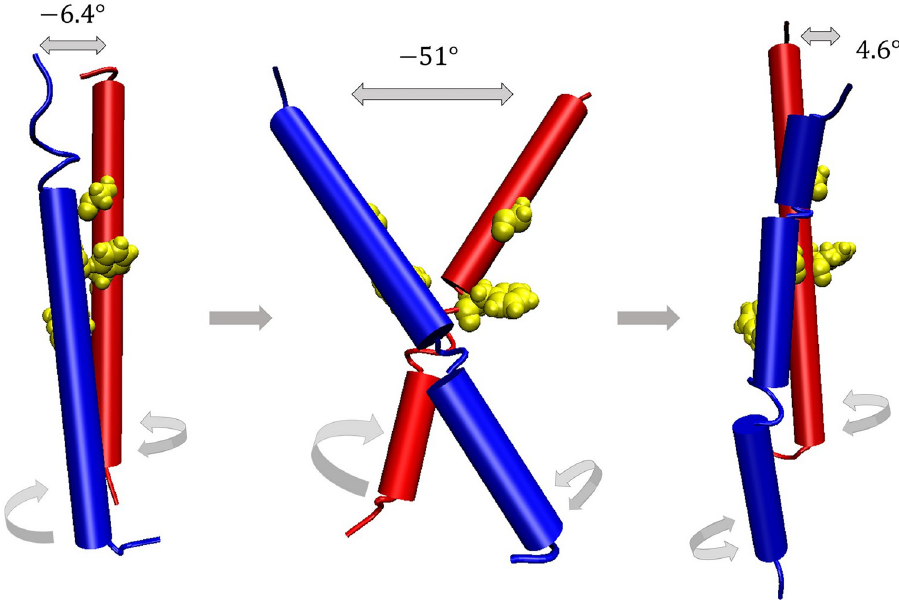
Fig 6. Schematic illustration of the inactivation mechanism. The blue / red cartoon representation designate helix A / B. TMD shows a pivoting motion during which helix B rotates. The sidechains of G770 and F777 are also shown in